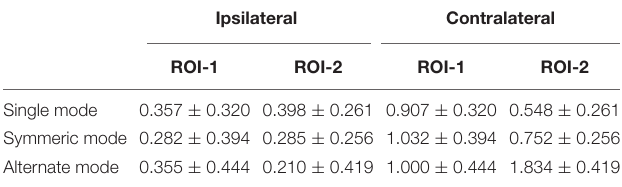
TABLE 1 | Mean ± Standard Error for each condition ( × 10 − 7 mol/L). Ipsilateral Contralateral ROI-1 ROI-2 ROI-1 ROI-2